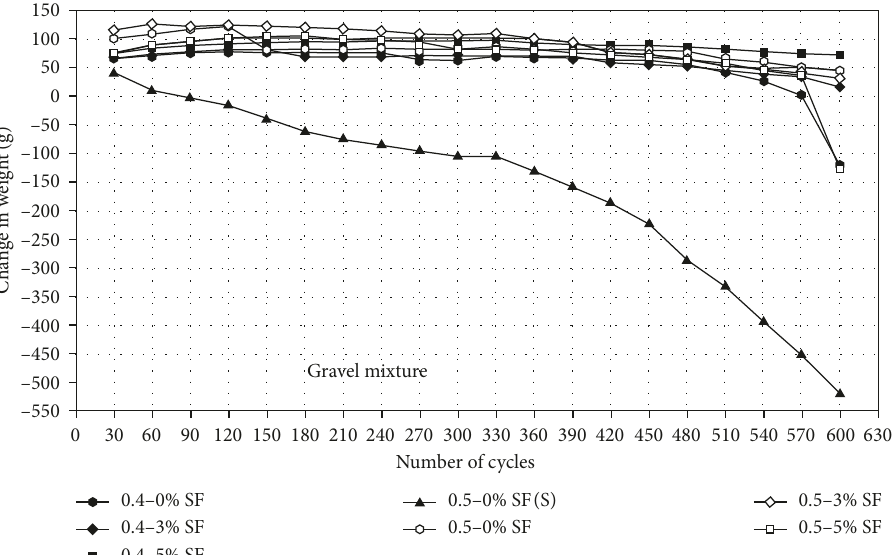
Figure 3: Weight change of beams for 600 freezing and thawing cycles (W/C ratio 0.4/0.5; silica fume content 0%, 3%, and 5%; 0.5–0% SF (S) sample with W/C 0.5, 0% silica fume, soaked in (cid:31)